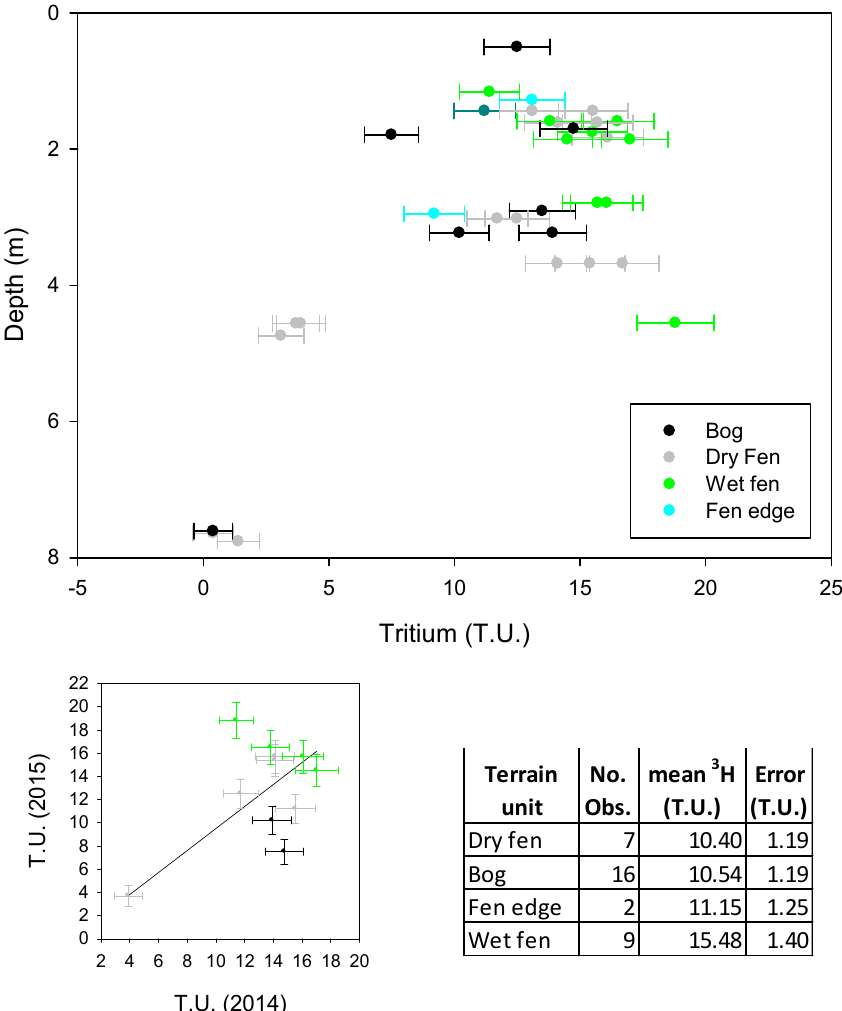
Figure 7. Tritium variations with depth at ML for various terrain units. Inset shows comparison of tritium measured in 2015 versus 2014. Averages for each terrain unit are tabulated and presented in order of increasing rates of turnover or hydrologic